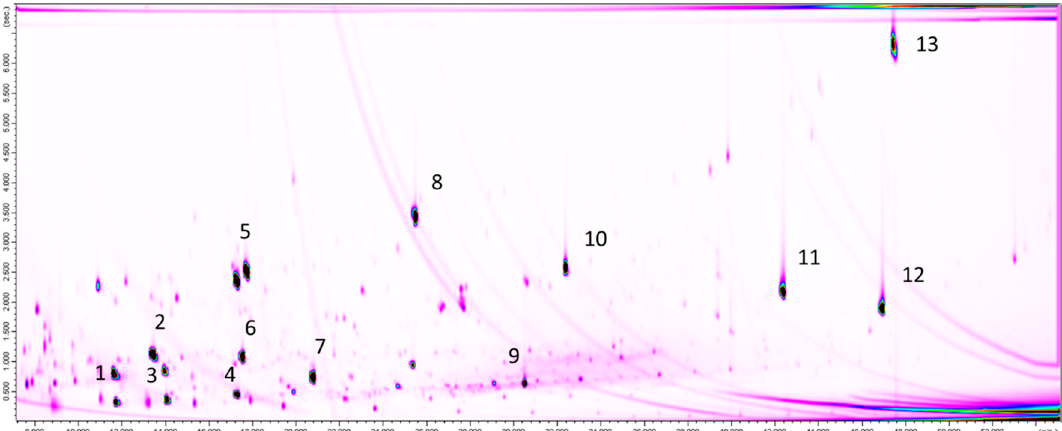
Figure 2. GC × GC-MS chromatogram of migration experiment using the chitosan acetate film Figure 2. GC×GC-MS chromatogram of migration experiment using the chitosan acetate film and the and the recycled paper donor. recycled paper donor. Internal standards marked with numbers; 1) n-undecane (C 11 ), 2) n- pentylbenzene (5B), 3) n-dodecane-d 26 (d-C 12 ), 4) n-tridecane (C 13 ), 5) 1-and 2-methylnaphthalene (1-